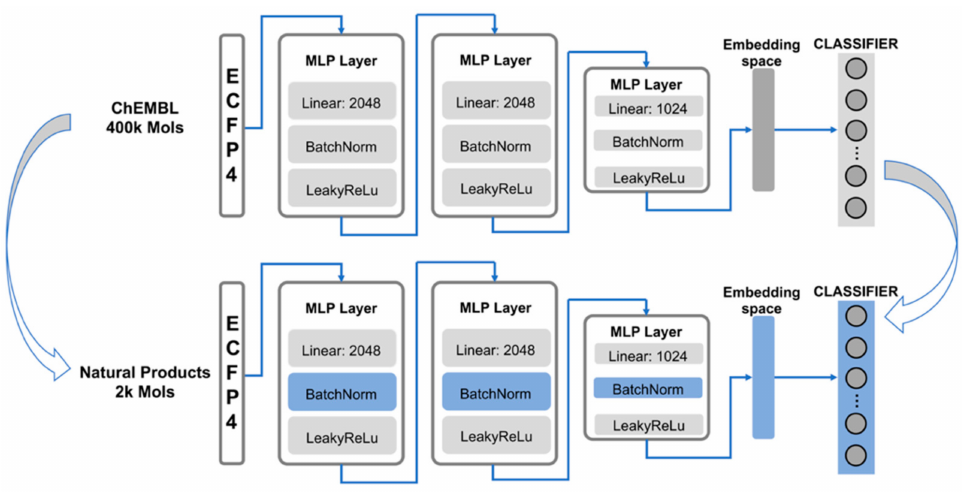
Figure 10. Model structure of the target prediction